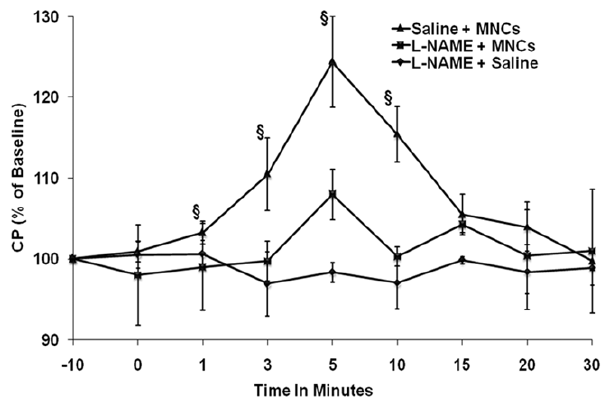
Figure 3. Time course of changes in cerebral perfusion after administration of MNCs at 24 hours after stroke. Changes in cerebral perfusion were measured with LDF over the peri-infarct region. Animals at 24 hrs after stroke were treated with L-NAME or saline 60 min before administration of MNCs IV. A third group of control animals received L-NAME followed by saline IV. 1 p , 0.05 refers to the group pre-treated with saline followed by IV MNCs compared with the group pre-treated with L-NAME followed by MNCs IV. ‘0’ on the x-axis represents the time in minutes, just before the injection. N=5 per group.